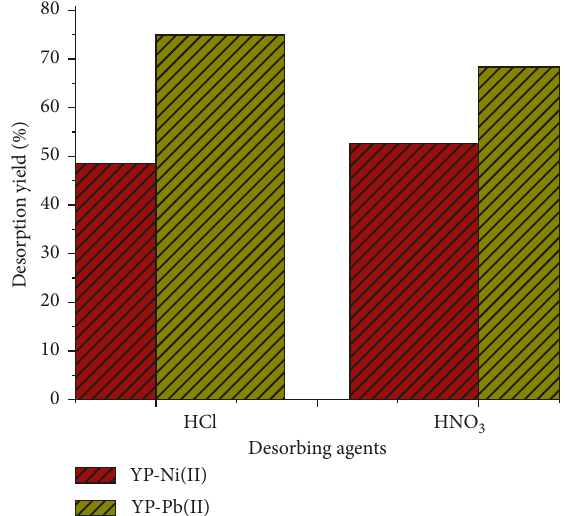
Figure 5: Effect of desorbing agent on desorption process.